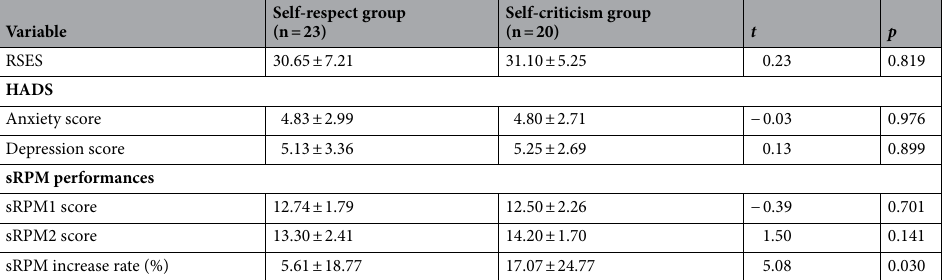
Table 1. Summary of psychological assessments and task performances in each self-talk group. Values are means ± standard deviation. RSES Rosenberg self-esteem scale, HADS hospital anxiety and depression scale, sRPM short form of Raven’s Progressive Matrices. sRPM increase rate = [(sRPM2 score – sRPM1 score)/sRPM1 score] ×